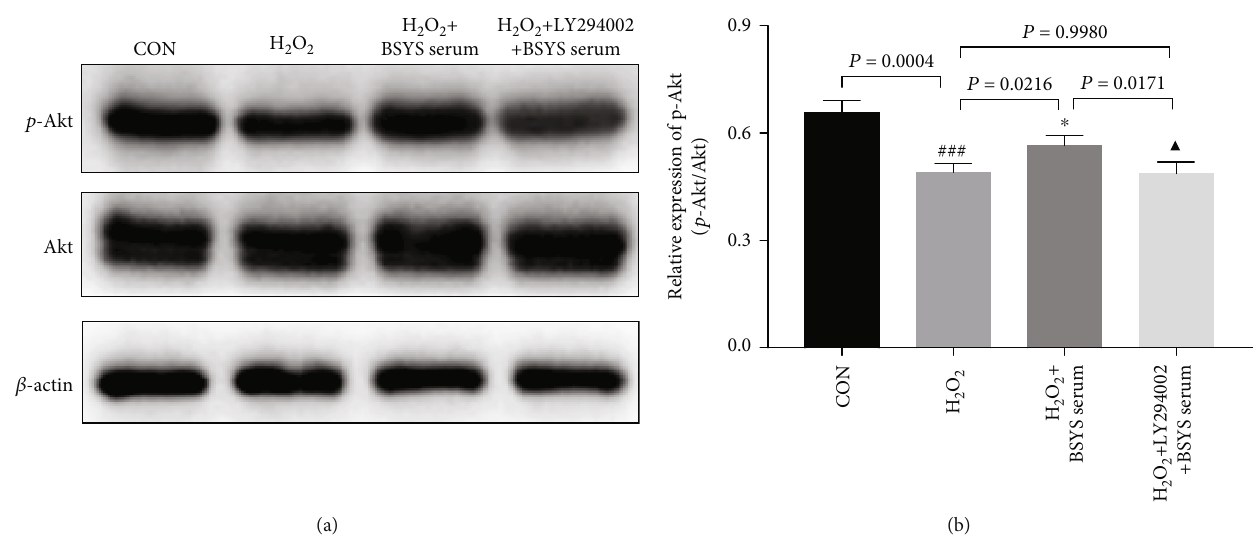
Figure 10: LY294002 blocks the promoting e ff ect of BSYS serum on H blot images and quantitative data of p-AKT and AKT in OLN-93 cells. Data are presented as means ± SD , compared with the CON group, ### P < 0 : 001 , compared with the H